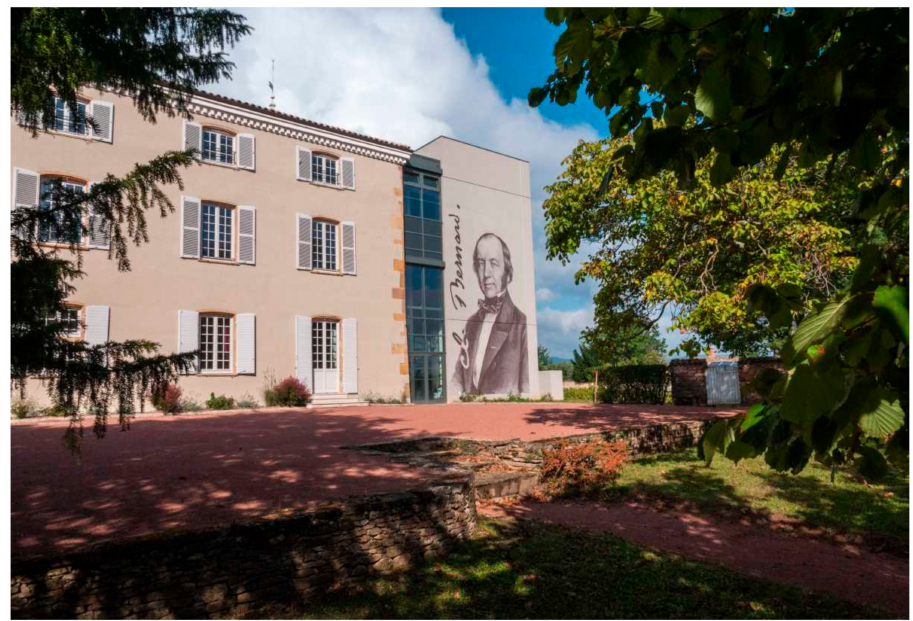
Figure 6. The Claude Bernard Museum in Saint Julien in